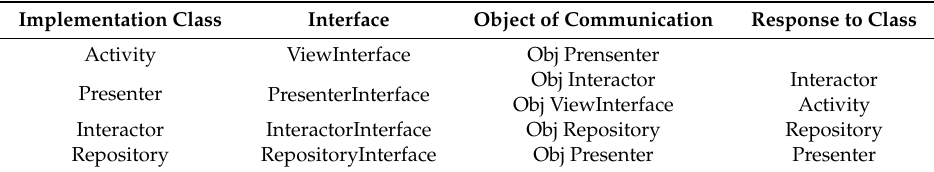
Table 4. Relationship between clean architecture and